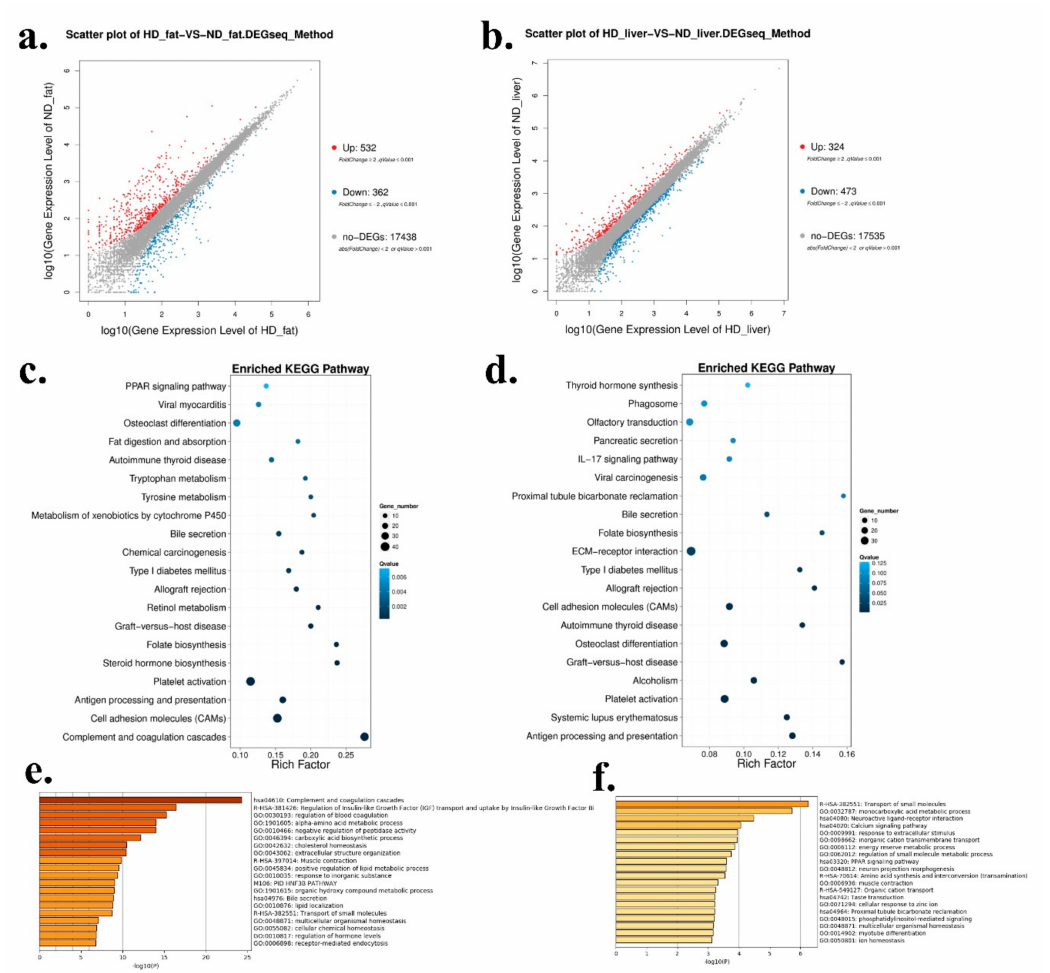
Figure 2. Di ff erentially expressed genes between HFD and ND chickens. ( a ) Scatter plot of di ff erentially expressed genes (DEGs) between HFD and ND chickens in abdominal fat. ( b ) Scatter plot of DEGs between HFD and ND chickens in liver. ( c ) Enriched Kyoto Encyclopedia of Genes and Genomes (KEGG) pathway of DEGs between HFD and ND chickens in abdominal fat. ( d ) Enriched KEGG pathway of DEGs between HFD and ND chickens in liver. ( e ) Gene Ontology (GO) enrichment of DEGs between HFD and ND chickens in abdominal fat. ( f ) GO enrichment of DEGs between HFD and ND chickens in